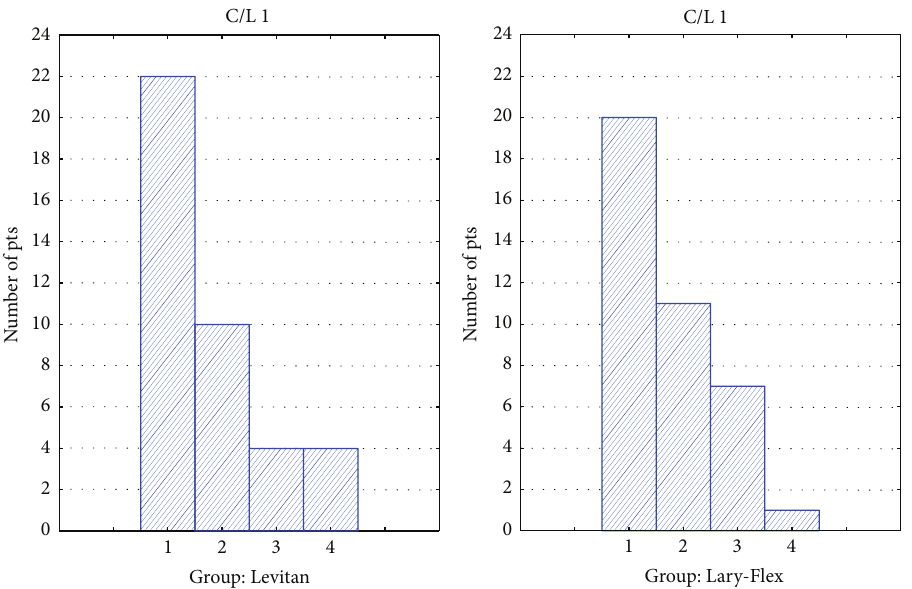
Figure 5: Histogram of evaluation of laryngeal view: Macintosh blade laryngoscope (Levitan group) or Lary-Flex as standard laryngoscope (Lary-Flex group).